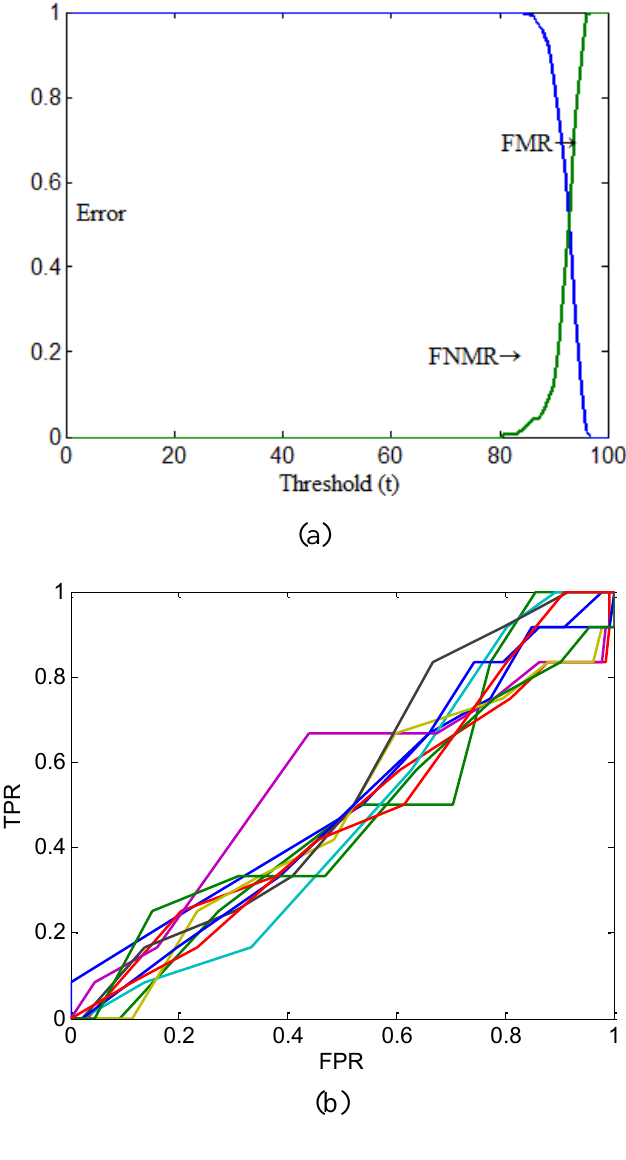
Figure 13. Test results for different representations (TPR: True Positive Rate, FPR: False Positive Rate). (a) FMR&FNMR representation; (b) ROC